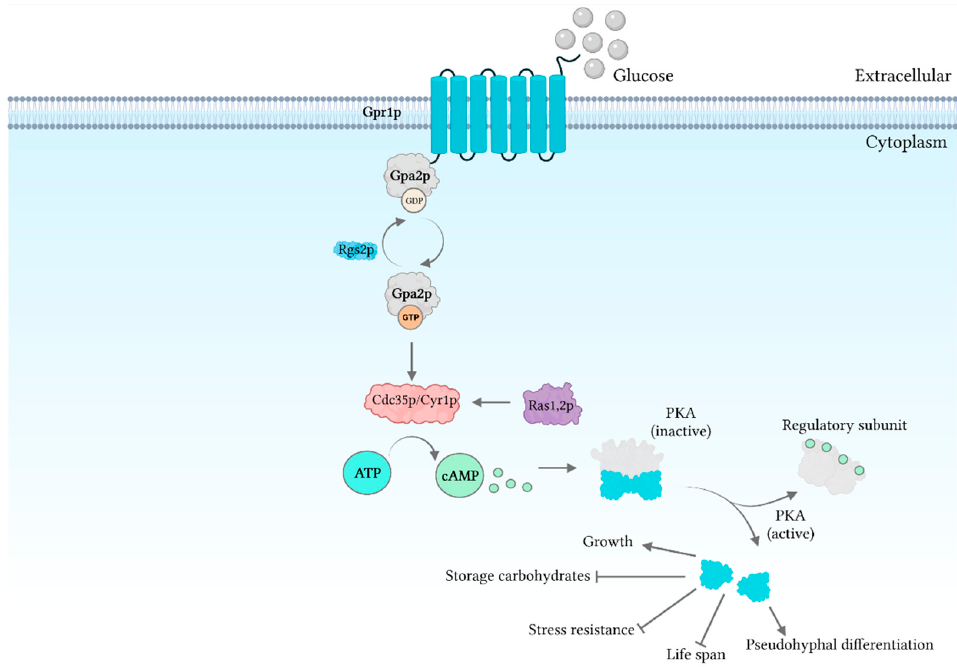
Figure 9. Schematic representation of the glucose signaling pathway in S. cerevisiae . The putative glucose receptor Gpr1p activates the G α protein Gpa2p. Rgs2p stimulates the GTPase activity of Gpa2p and inhibits glucose-induced cAMP signaling. Gpa2p in turn activates adenylate cyclase (Cdc35p/Cyr1p). The function of adenylate cyclase also depends on the Ras1p and Ras2p. Activation of the PKA by cAMP results in stimulation of growth and differentiation, loss of stress resistance, mobilization of carbohydrates and in reduced life-span.